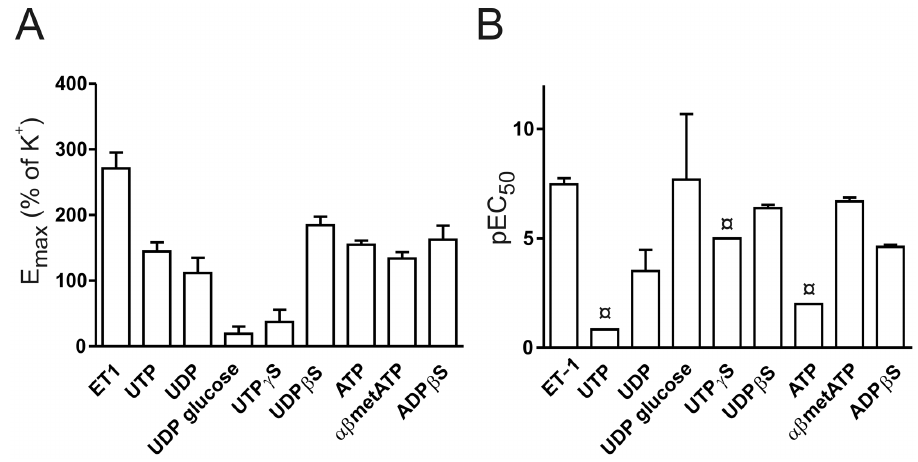
Figure 6. E max and pEC 50 of the purinergic agonists. A) E max values are presented and are the max value obtained at maximum concentration used in the above experiments. The E max is therefore not the absolute max concentration. B) pEC 50 values, calculated using non-linear regression in graph pad. For the curves with no clear E max and therefore a large STD, pEC 50 values are only estimates and are denoted with ¤.